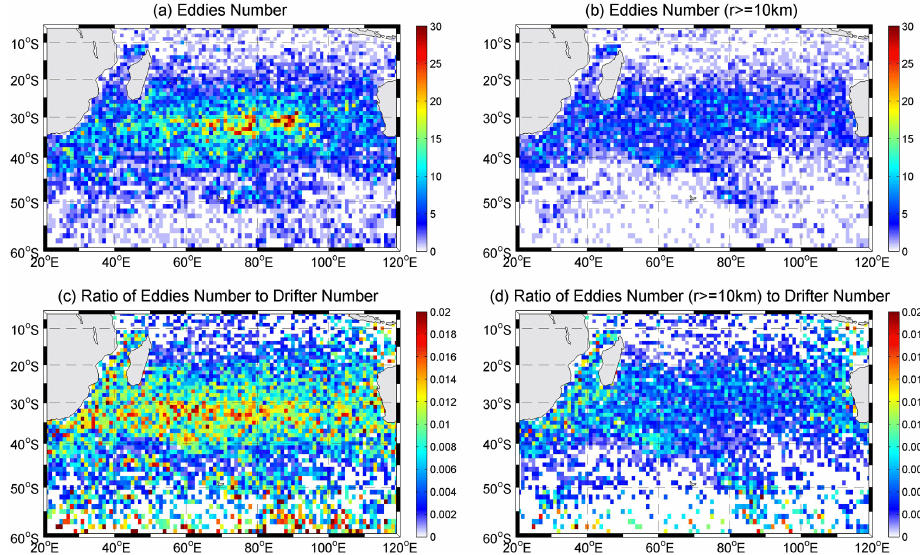
Figure 7. (a) Number of eddies detected in 1 ◦ × 1 ◦ bins. (b) Number of eddies with radii equal or greater than 10km detected in 1 ◦ × 1 ◦ bins. (c) Ratio of number of eddies to number of drifters in 1 ◦ × 1 ◦ bins. (d) Ratio of number of eddies with radii equal or greater than 10km to number of drifters in 1 ◦ × 1 ◦